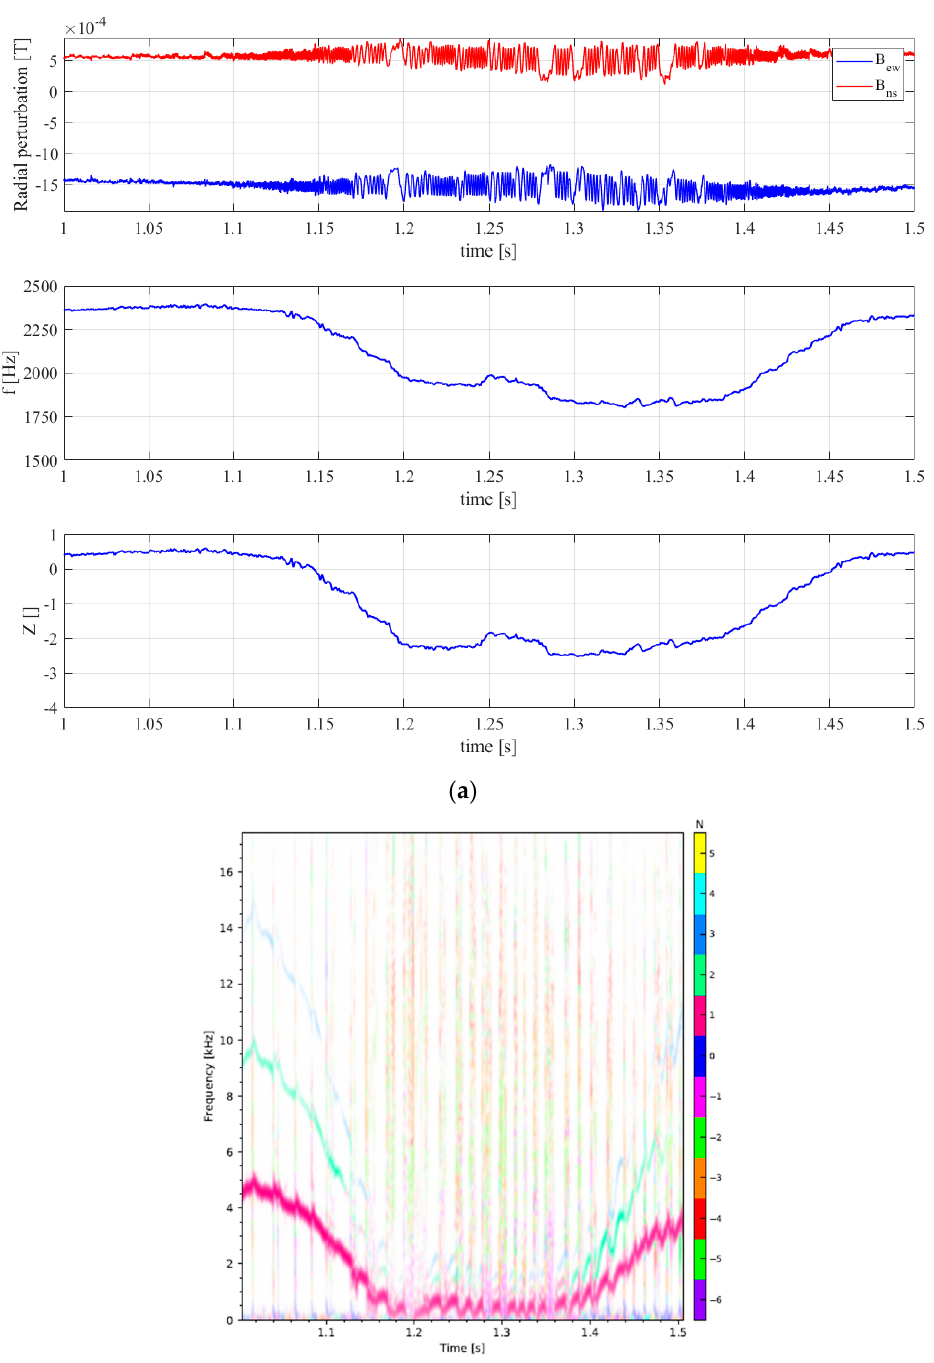
Figure 8. Plot for the pulse 30445 having a disruptive event at t = 7.571 s. ( a ) Top: the integrated radial perturbations are shown for the two π -faced couples of coils (ew and ns). ( a ) Middle: mode average frequency estimator; ( a ) bottom: Z normalized average frequency rotation, i.e., Z ( f ( t i ) , mean ( f ( t ∈ [ t 0 , t i − 1 ])) , std ( f ( t ∈ [ t 0 , t i − 1 ])) ; t i ) obtained from Equation (8); ( b ) Mirnov coil spectrogram in the time window considered. As it can be seen a n = 1 mode slows down, almost locks to the wall and then starts rotating again.